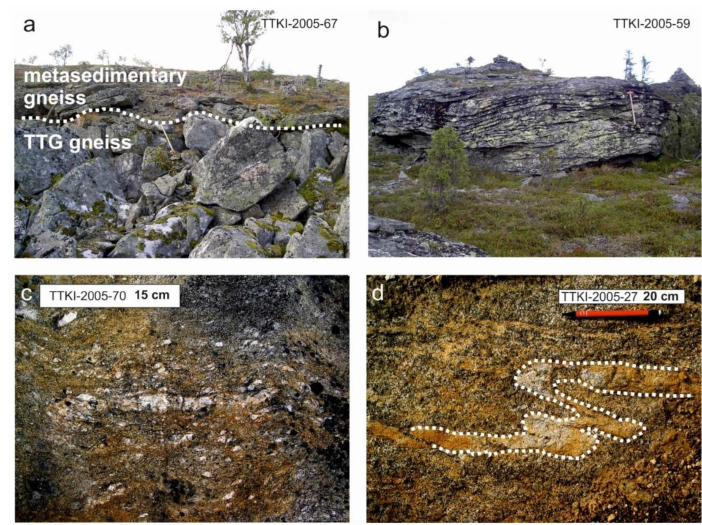
Figure 3. Structures in the Tuntsa gneisses. The exposure code and the length of the bar are given in the inset of each figure; map coordinates are given in Supplementary Materials, Table S1. ( a ) subhorizontal foliation (S2) in a metasedimentary gneiss which overlies a TTG gneiss. The tectonic contact (marked with a white dotted line) is above the hammer in the middle of the photograph; ( b ) a typical late subhorizontal S2 foliation in a metasedimentary gneiss; ( c ) fractured leucosomes in a staurolite- and kyanite-bearing gneiss showing the S2 foliation; ( d ) folded leucosomes (emphasized with white dotted lines) in staurolite-bearing metasedimentary gneiss.